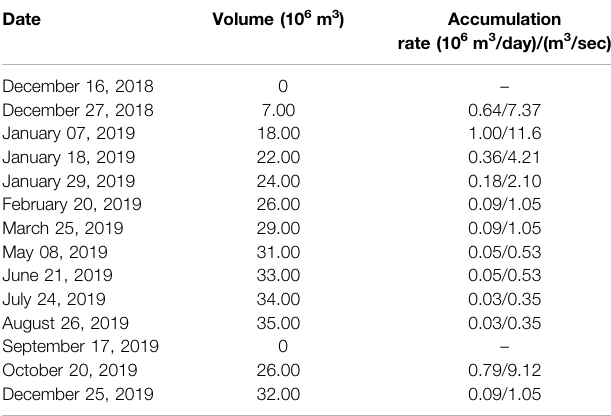
TABLE 2 | Minimum volumetric accumulation of deposits and corresponding deposition rates in the western and eastern collapse scars